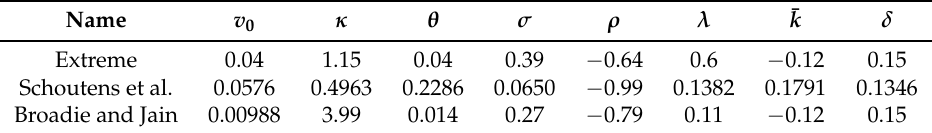
Table 7. Bates parameters.